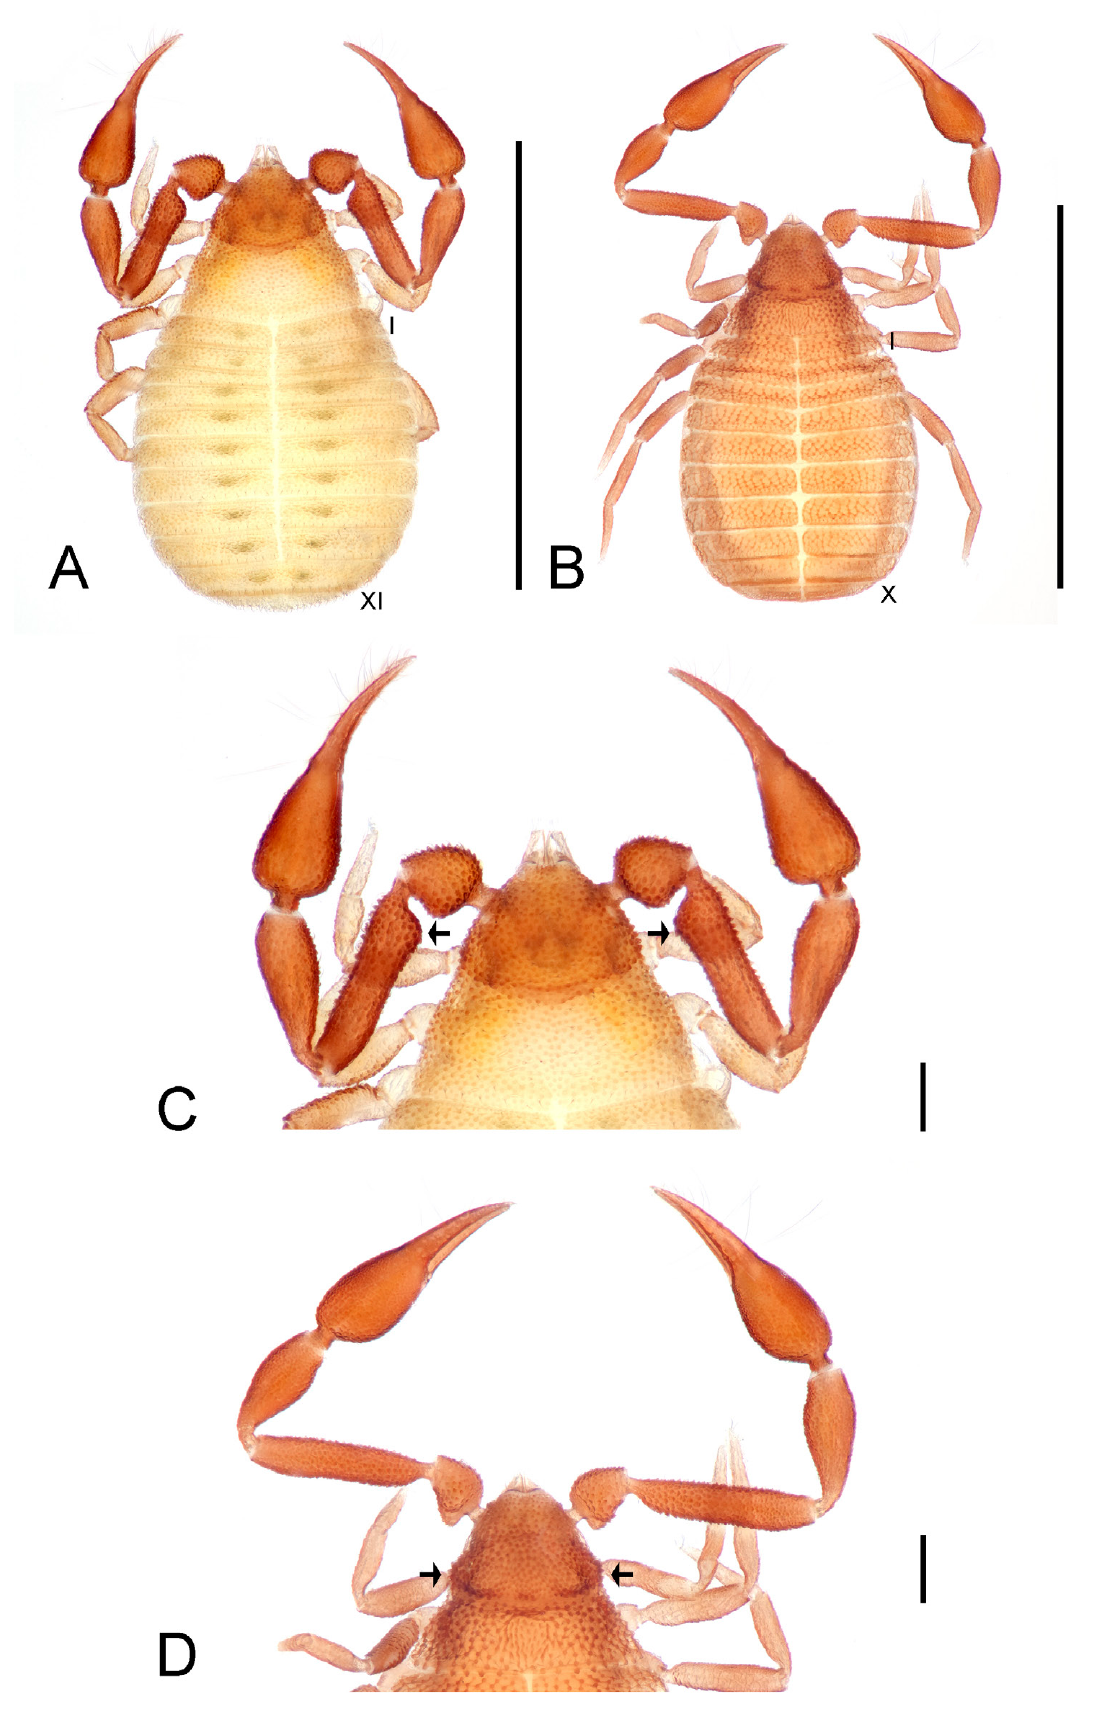
Figure 3. Some morphological characteristics of Apocheiridium ferum and Cheiridium museorum . A. Female of A . ferum with numbered tergites (scale bar = 1 mm). B. Female of C . museorum with numbered tergites (scale bar = 1 mm). C. Details of carapace and pedipalps of A . ferum , arrows point to the shape of palpal femur (scale bar = 0.1 mm). D. Detail of carapace and pedipalps of C . museorum , arrows point to humeral angles (scale bar = 0.1